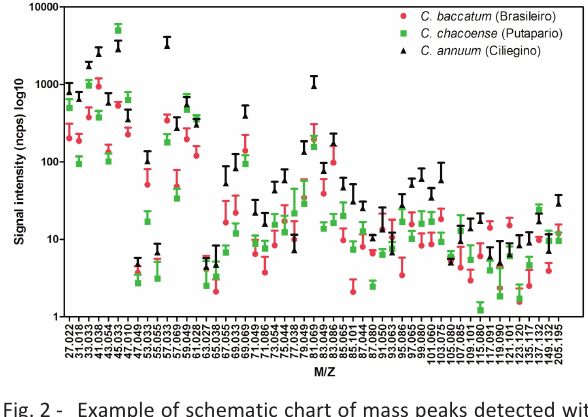
Fig. 2 ­ Example of schematic chart of mass peaks detected with H O + ion as reagent for each capsicum species used in 3 this paper. Signal intensities are given in normalize count per second (ncps) log ­1 and higher than